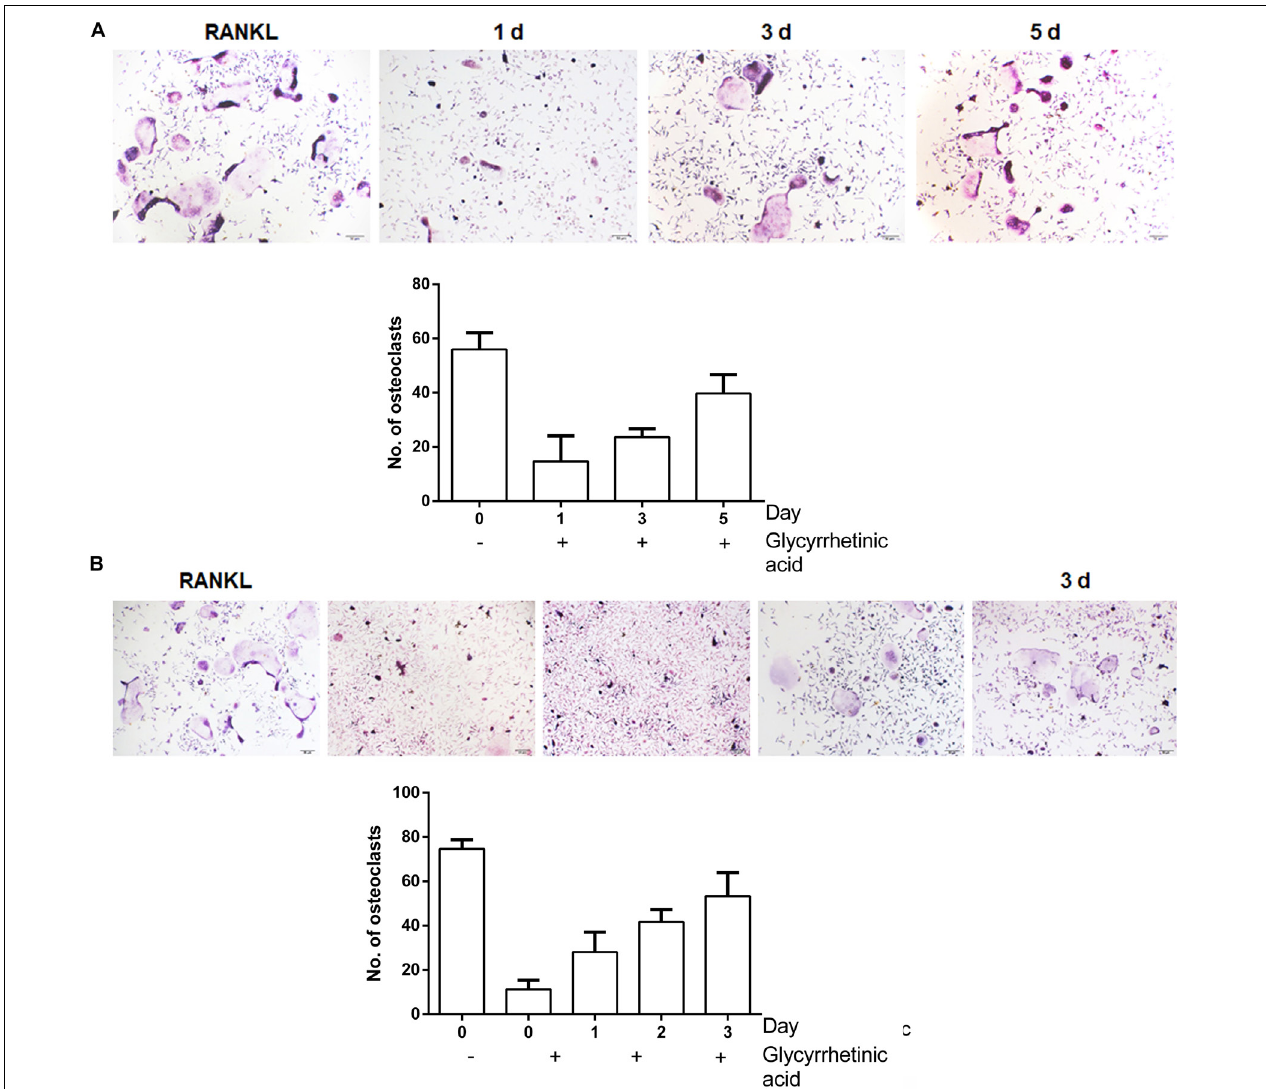
FIGURE 3 | 18 β -GA inhibits RANKL-induced osteoclast formation at the early stage. (A) Effect of 18 β -GA on RANKL-induced primary osteoclast precursor differentiation at different stage. (B) Effect of 18 β -GA on RANKL-induced RAW264.7 cell differentiation at different